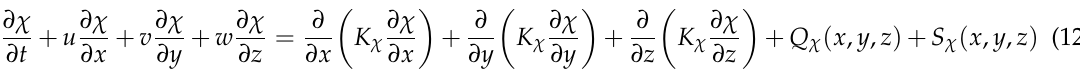
Table 2. Dominant chemical reaction chain in the microclimate model ENVI-met.